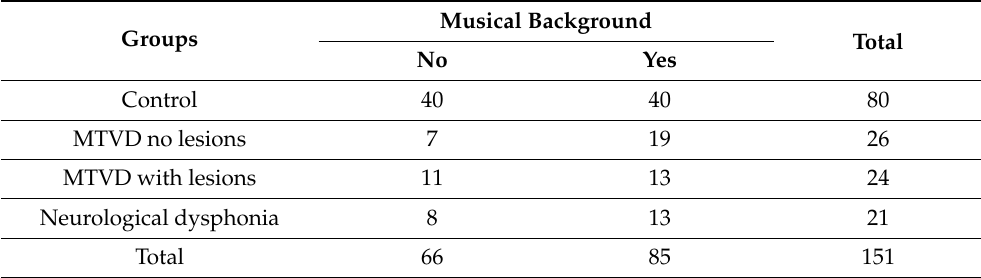
Table 1. Number of participants by groups. MTVD: muscle tension voice disorder.